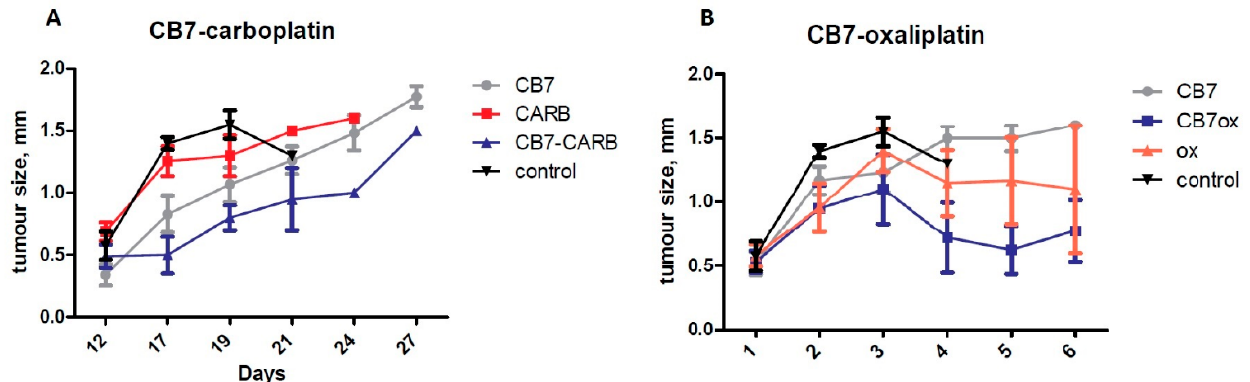
Figure 6. Effects of the CB[7] and platinum drugs on mice survival in melanoma model. ( A ) Impact of the mixture of CB7 and carboplatin (1:1) on mice survival. ( B ) Impact of the oxaliplatin–CB[7] complex on mice survival.